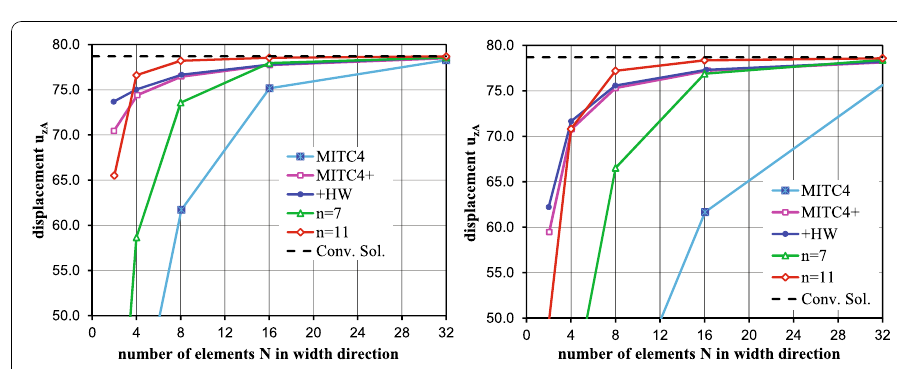
Fig. 26 Hook problem: distorted mesh and flat projection for a 4 × 8 × 12 mesh